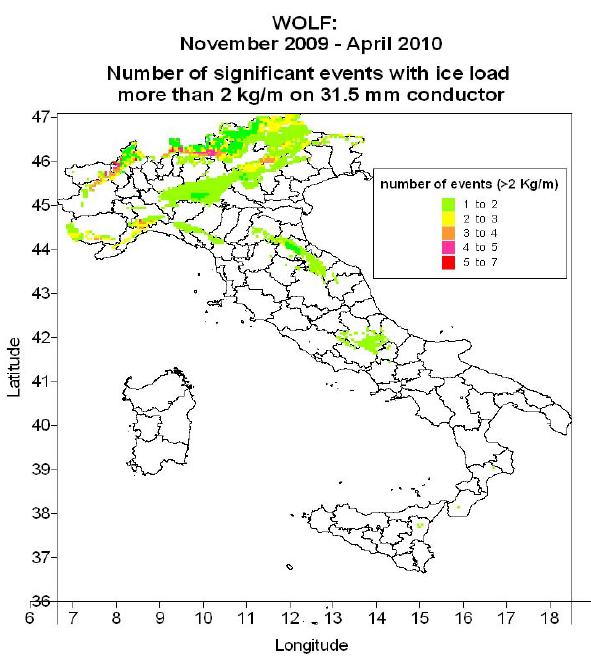
Fig. 10. Geographical distribution of significant events (ice load greater than 2Kgm − 1 ) forecasted by